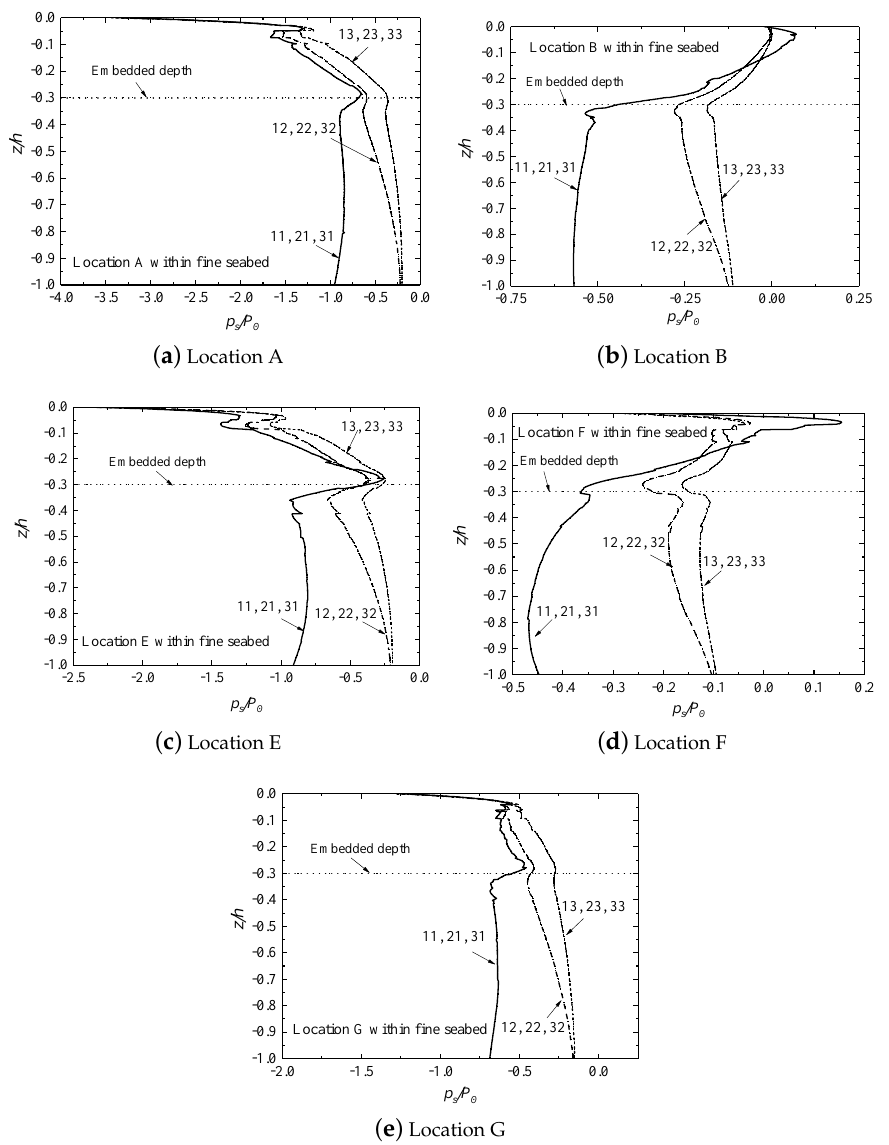
Figure 17. Vertical distributions of pore pressure at characteristic locations within a fine seabed at t = 83.5